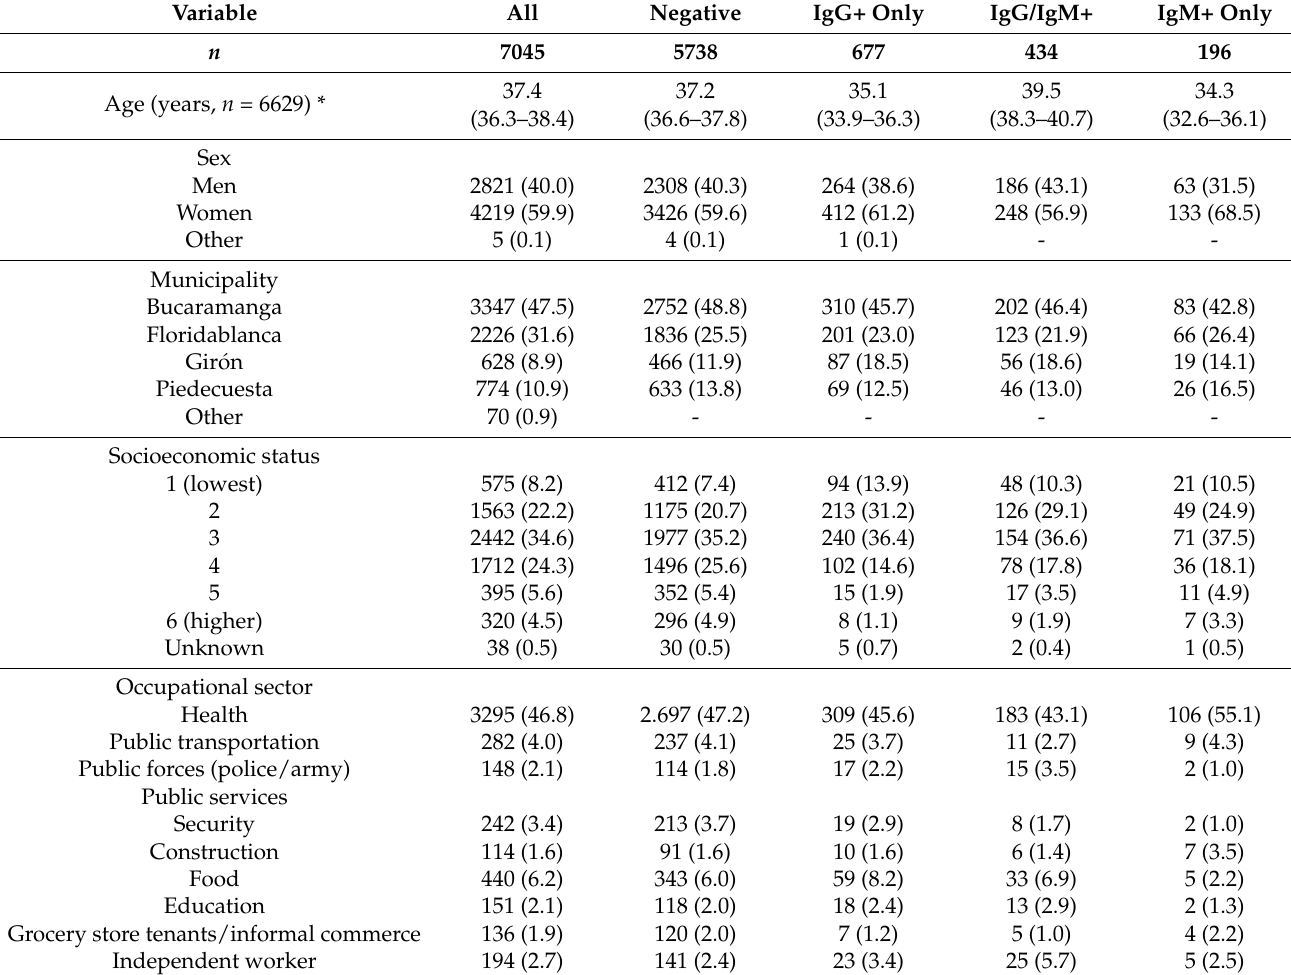
Table 1. Sociodemographic variables of the study participants according to immunoglobulin type a